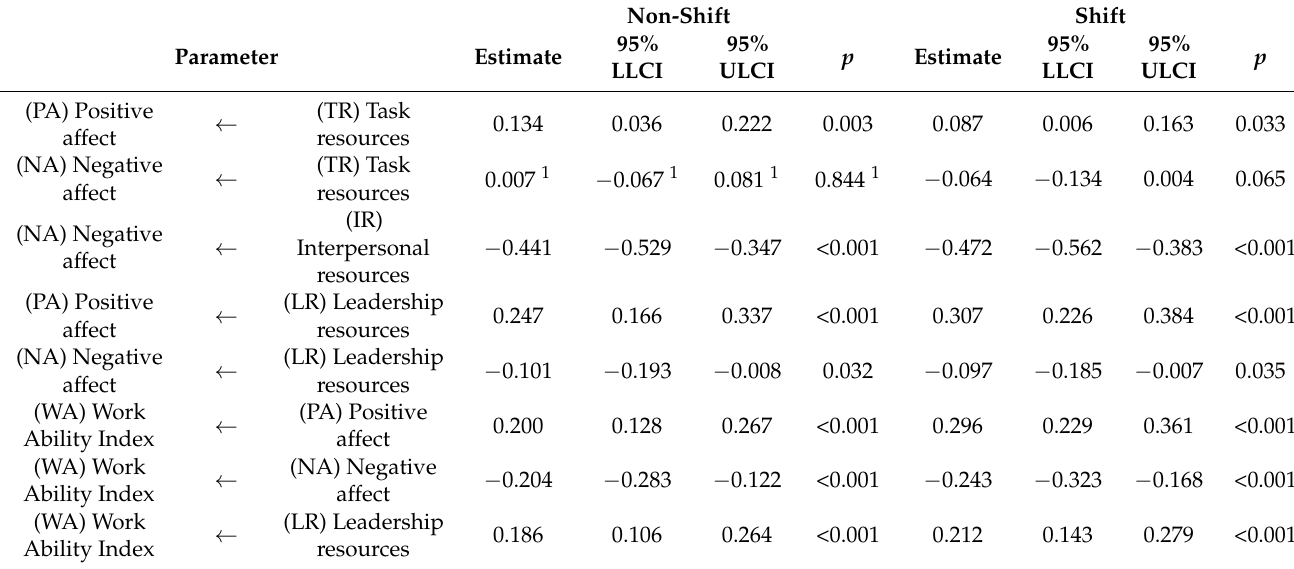
Table 4. Standardised estimates with 95% bootstrap confidence